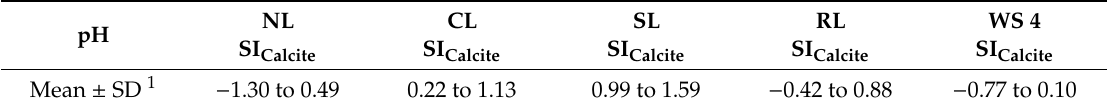
Table 2. Saturation index (SI) for calcite.